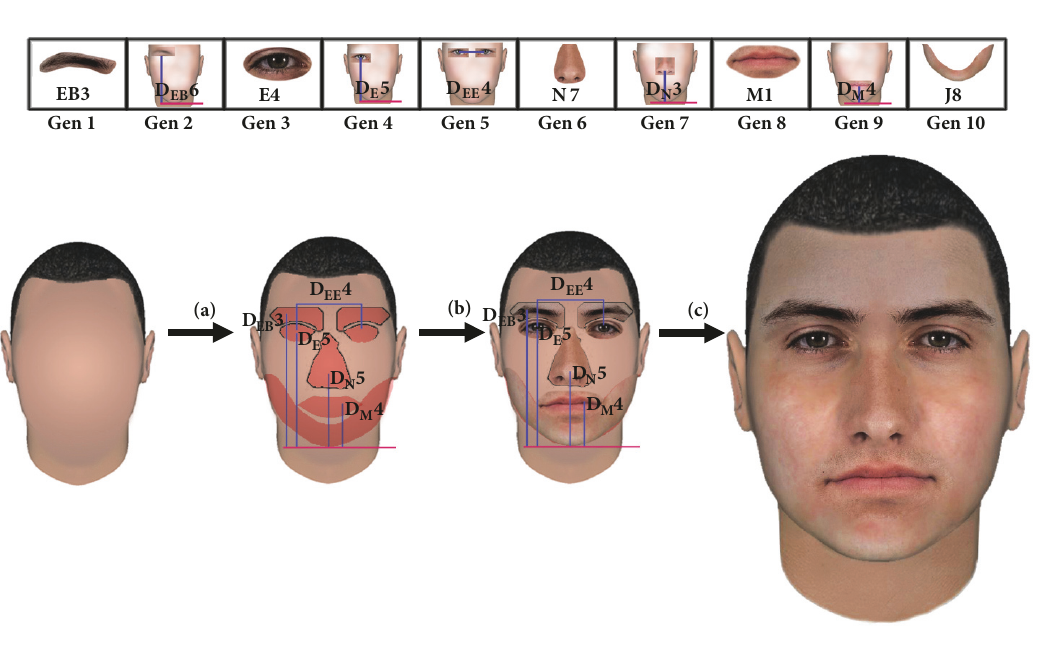
Figure 7: Generating a realistic looking face from a chromosome combining facial features. (a) Mask positioning. (b) Pasting the features. (c) Applying the Poisson Image Editing method.